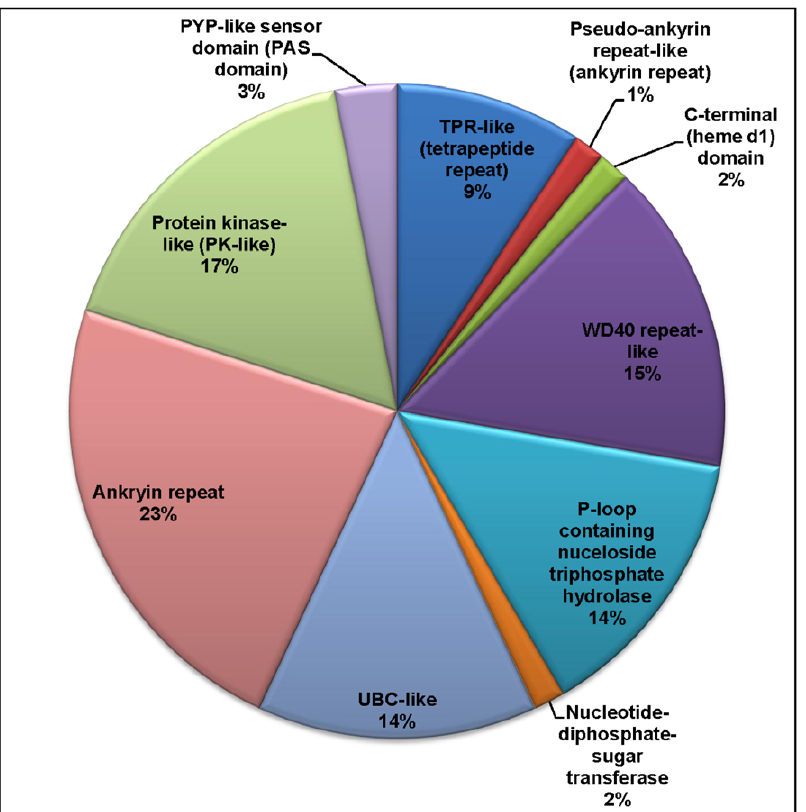
Figure 7. Classification of 65 SCOP domains into superfamilies. These are the SCOP domain superfamilies that co-occur with the HET-s protein domains. Ten superfamilies are represented.